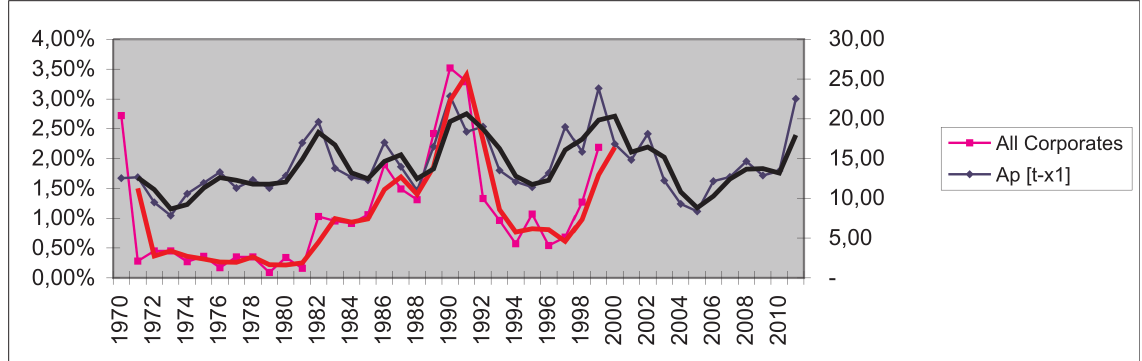
Fig 2. Yearly time series: Moody’s Year Default Rate (for all corporates, source: Moody’s) and geomagnetic activity index Ap [t-x1] – with time lag x1 and their moving